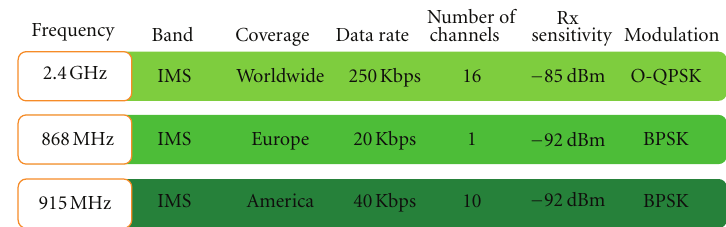
Figure 1: IEEE 802.15.4 radio characteristics.